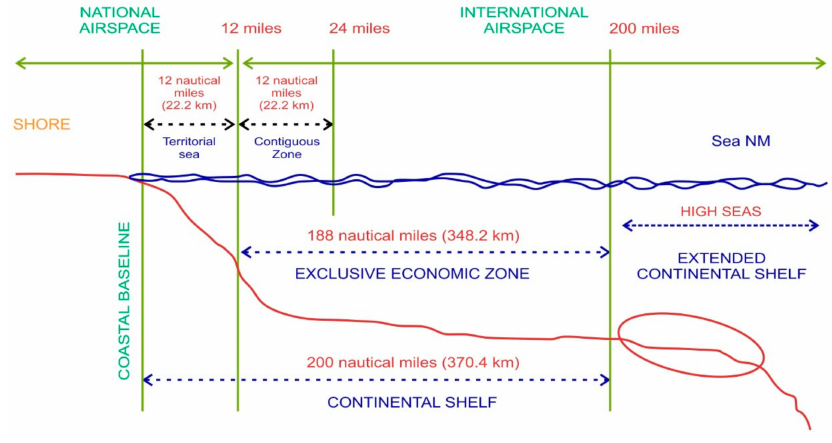
Figure 3. EEZ divisions. Source: